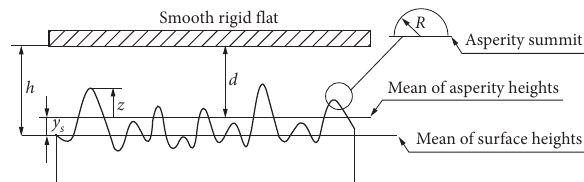
Figure 3: Schematic diagram of contact between a rough surface and a smooth rigid